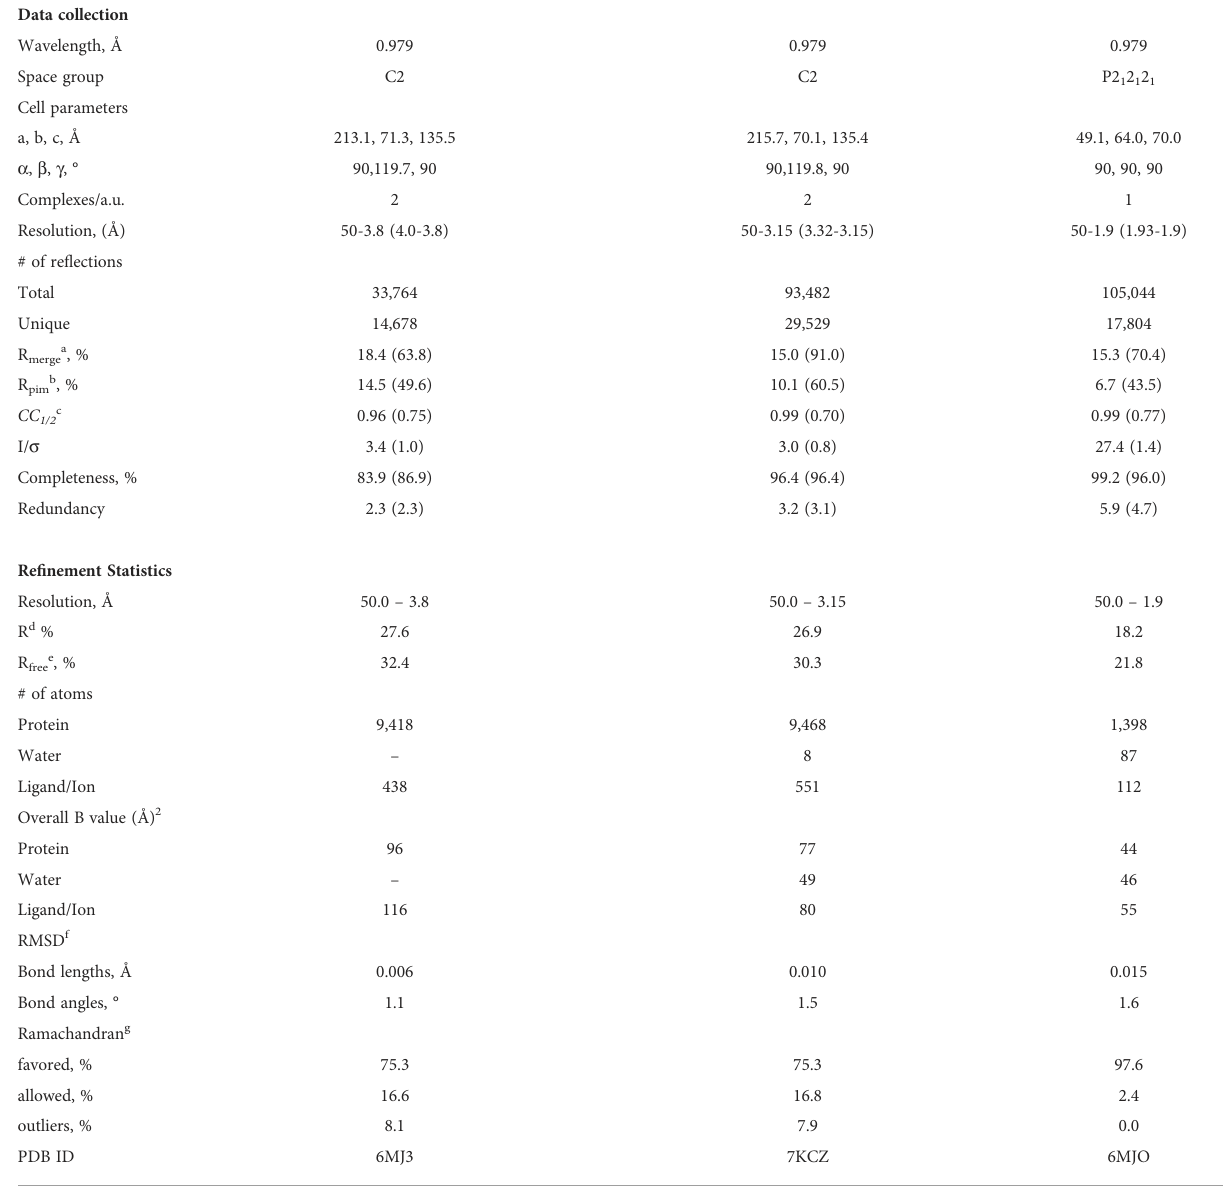
TABLE 2 Data collection and re fi nement